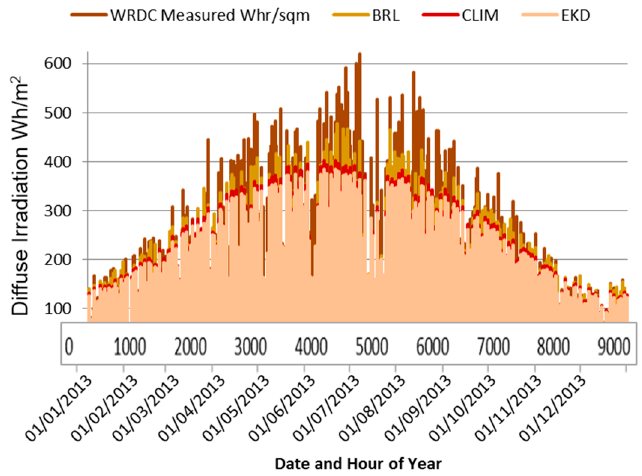
Figure 5. Comparison between Diffuse Irradiation values from three separation models and measured values: Camborne 2013.